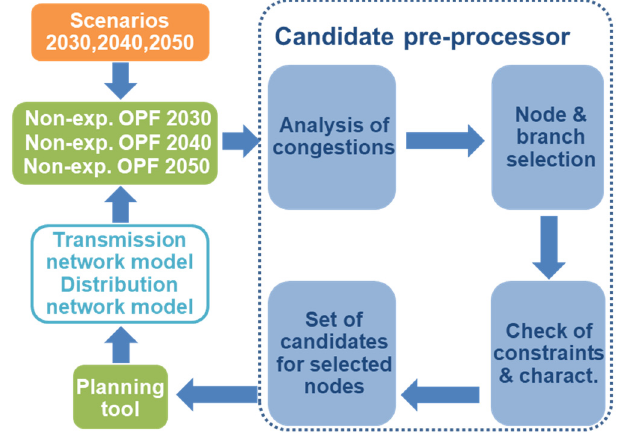
Figure 8. Steps by the flexibility candidate